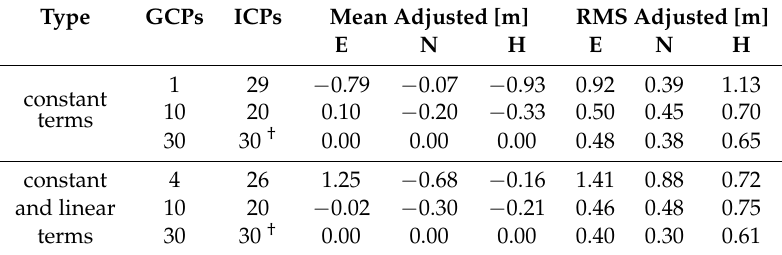
Table 7. 3D geo-location accuracy analysis using different adjustment settings for the Innsbruck stereo set ( † ICPs equal GCPs). Values are given for East (E), North (N) and Height (H).